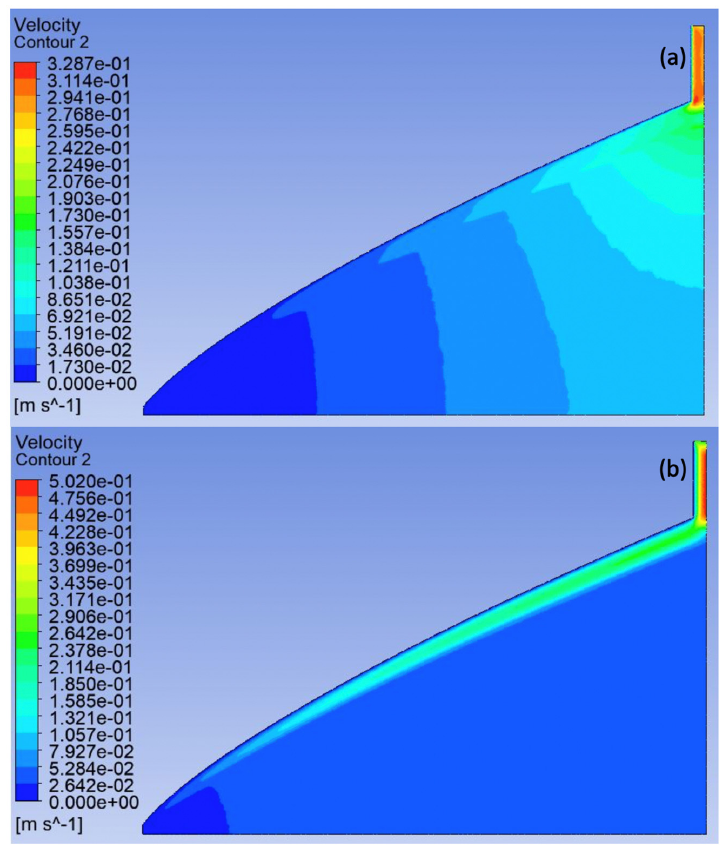
Figure 7. Velocity contour plots of extrusion: ( a ) material #2 and ( b ) material #3.